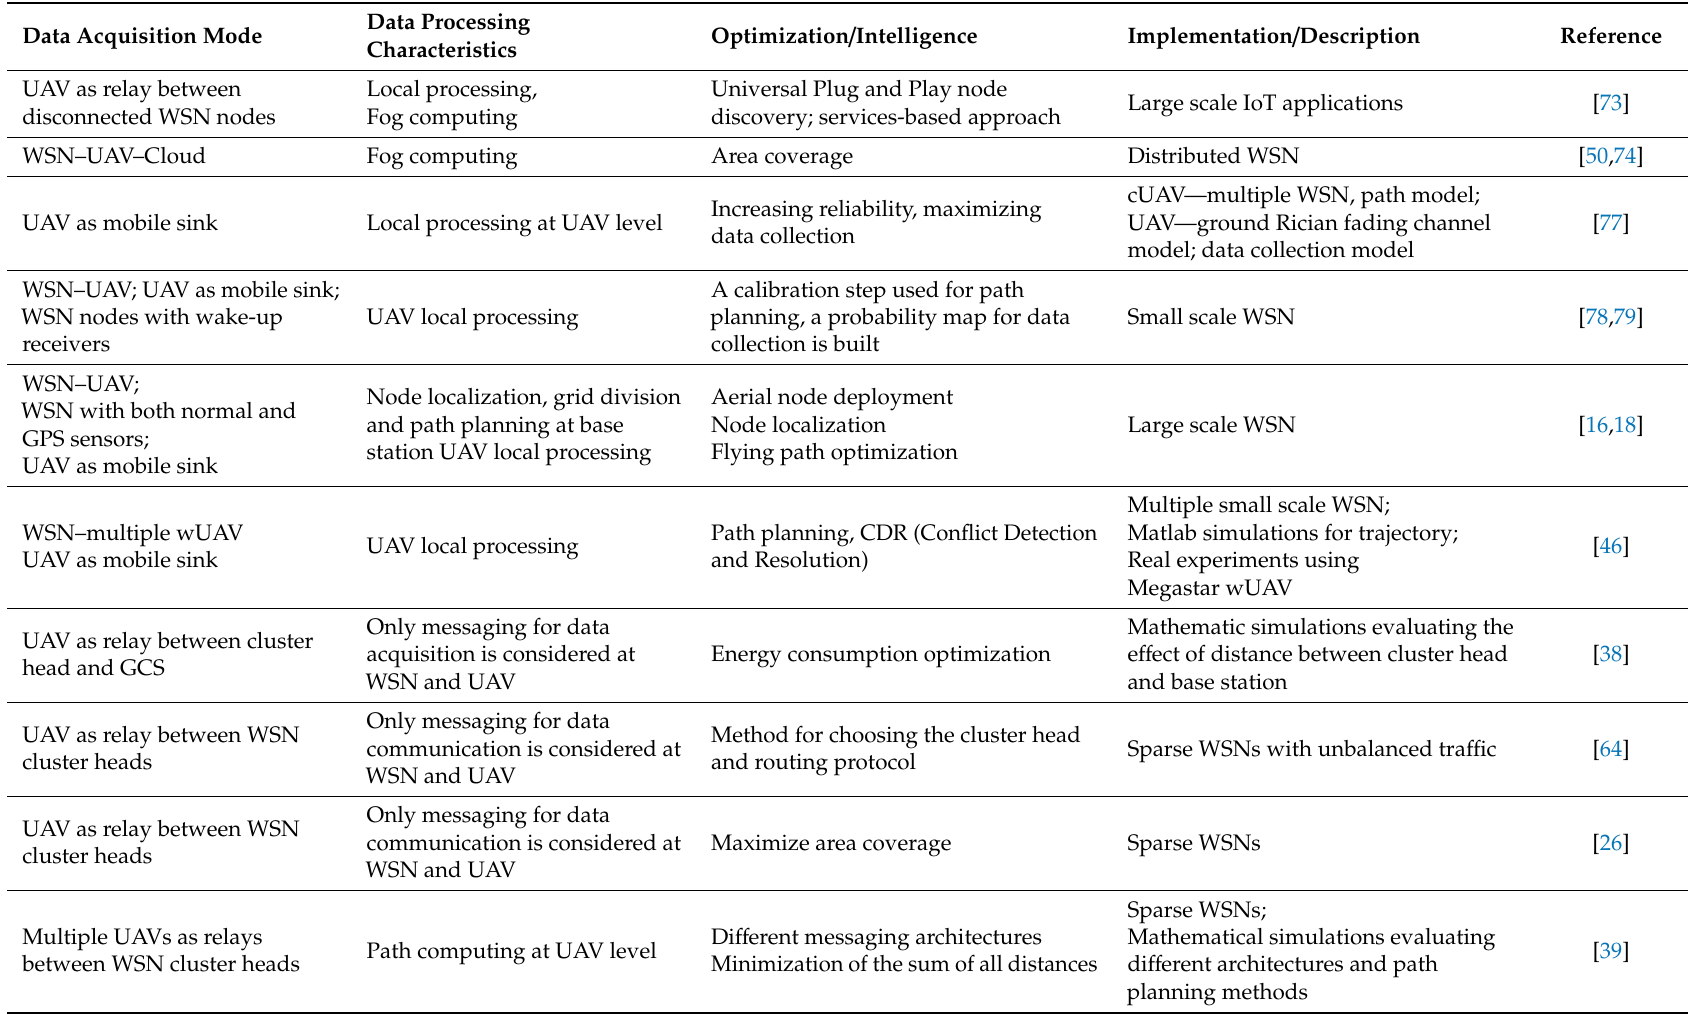
Table 2. Data acquisition and processing in integrated UAV–WSN